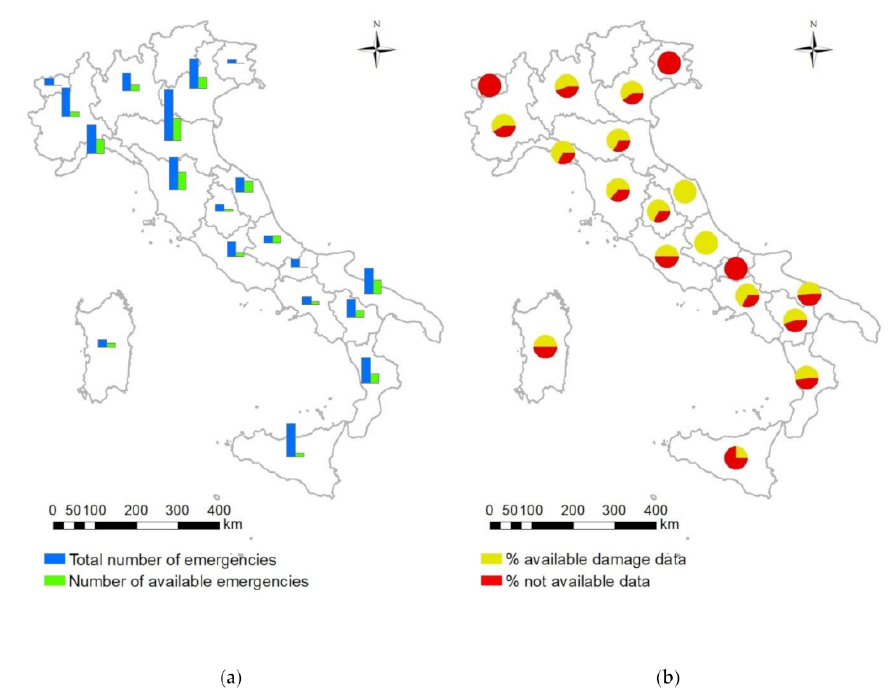
Figure 2. The maps represent the total availability of damage information referred to public services, private properties, and commercial activities altogether. Map ( a ) represents the number of emergen- cies available for our work (blue columns), with respect to the total number of states of emergency declared in each region (green columns). Map ( b ) represents the proportion of the number of states of emergency of which we collected every single claim (yellow slice) and the number of states of emergency that present damage recognition on the Civil Protection website.